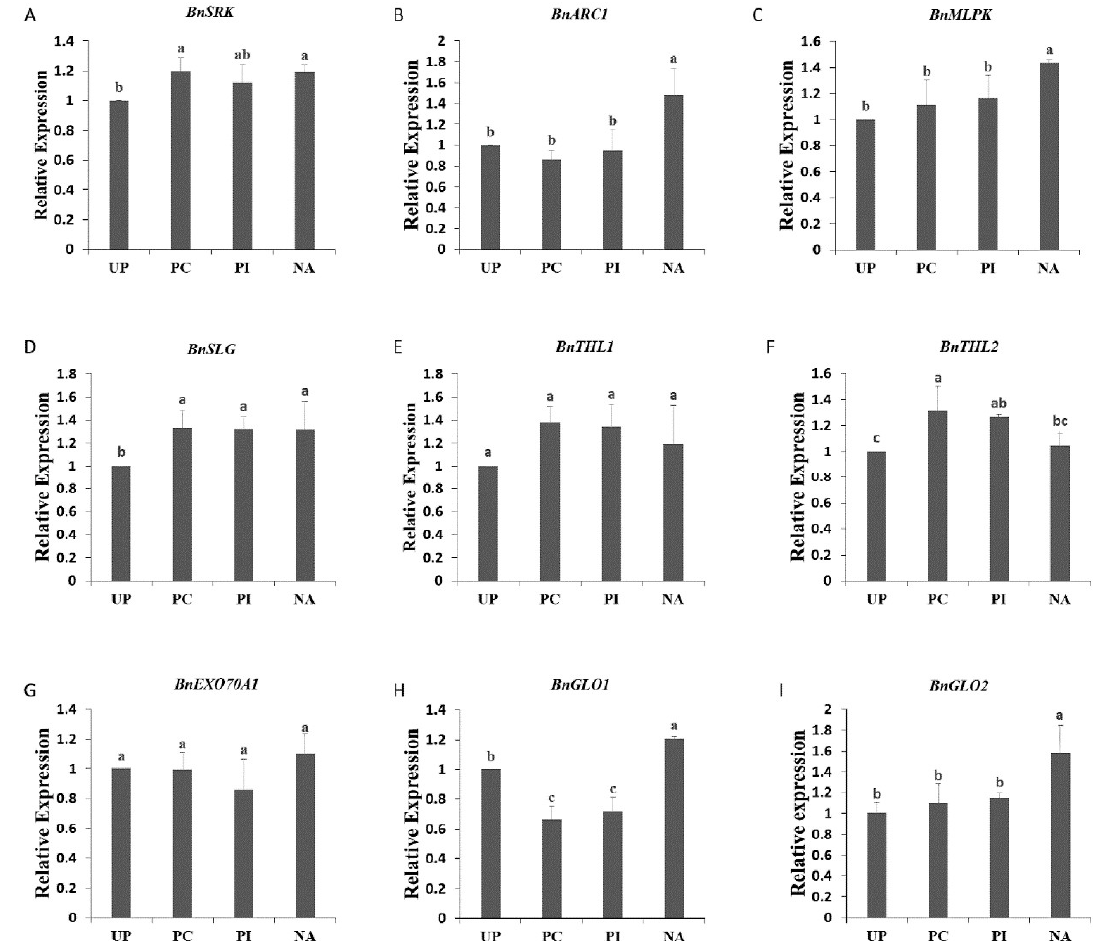
Figure 2. Expression analysis of SI-related genes, BnSRK (A), BnARC1 (B), BnMLPK (C), BnSLG (D), BnTHL1 (E), BnTHL2 (F), BnEXO70A1 (G), BnGLO1 (H), and BnGLO2 (I) in “Westar” stigmas. UP: unpollinated; PC: pollinated with “Westar” pollen grains; PI: pollinated with “W-3 pollen grains”; NA: pollinated with “W-3” pollen grains after edible salt solution treatment. The different letters are significantly different at p < 0.05. Error bars indicate standard deviation.